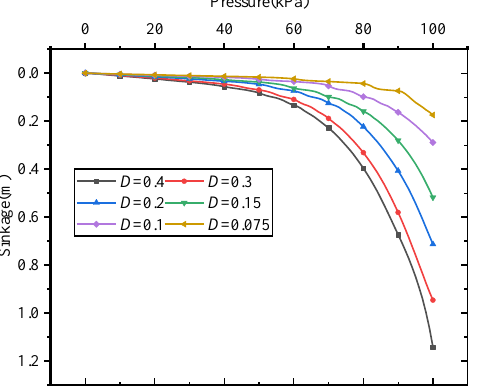
Circle Plate Figure 19. Schematic diagram of the rectangle plate and the circle plate. ( a ) ( b ) Figure 20. ( a ) Comparison of maximum displacements under different L/B ratios and ( b ) pressure- sinkage curves when L/B = 6 and 8.